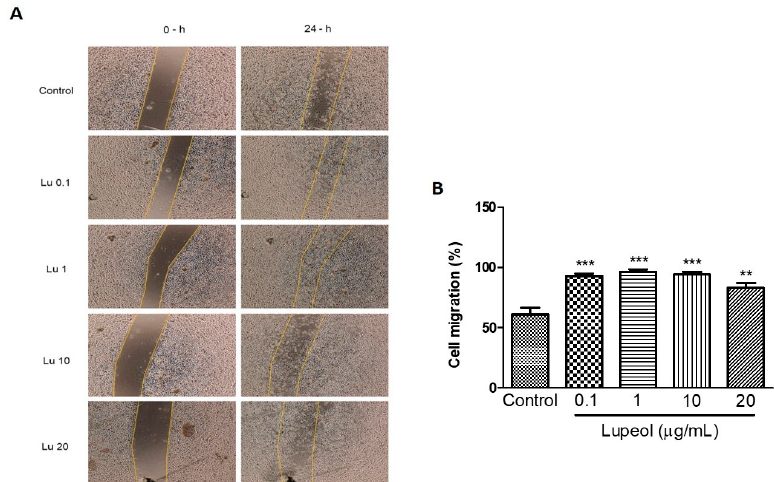
Figure 4. Keratinocyte migration using a scratch assay after 24 h of incubation with lupeol. Cells were